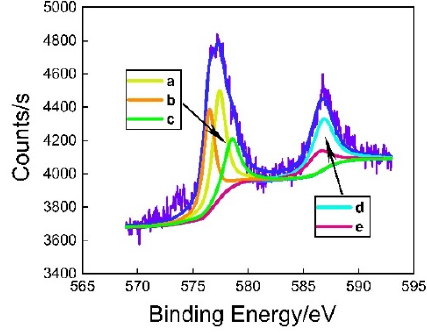
Figure 10. The fitting curve of the Cr XPS in the TFS. Figure 10. The f itting curve of the Cr XPS in the TFS. Table 2. The curve fitted by XPSPEAK corresponds to the compound in Table 1. The element content of the TFS surface.